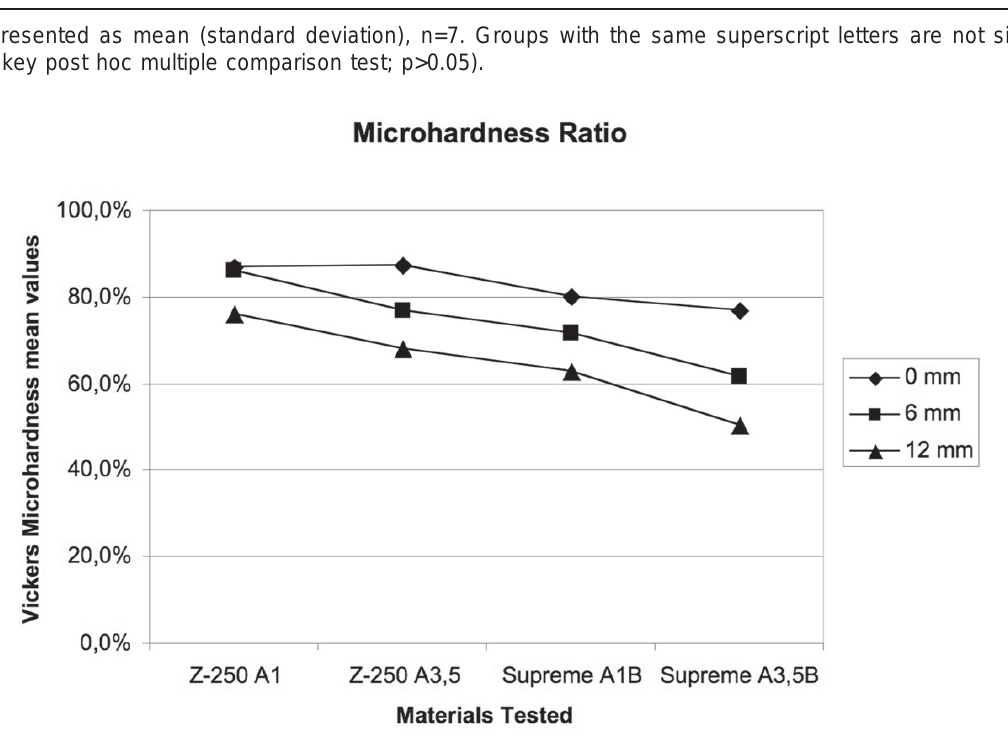
FIGURE 1- Microhardness ratio of the tested materials. The values accepted as satisfactory were at least equal or greater than